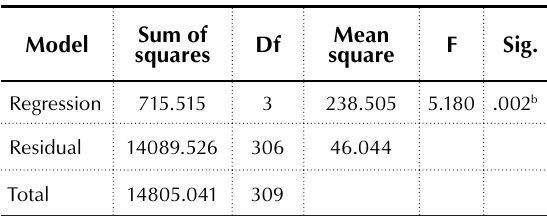
Table 4. FANOVA a Statistic test results Source: Processed data of the research result